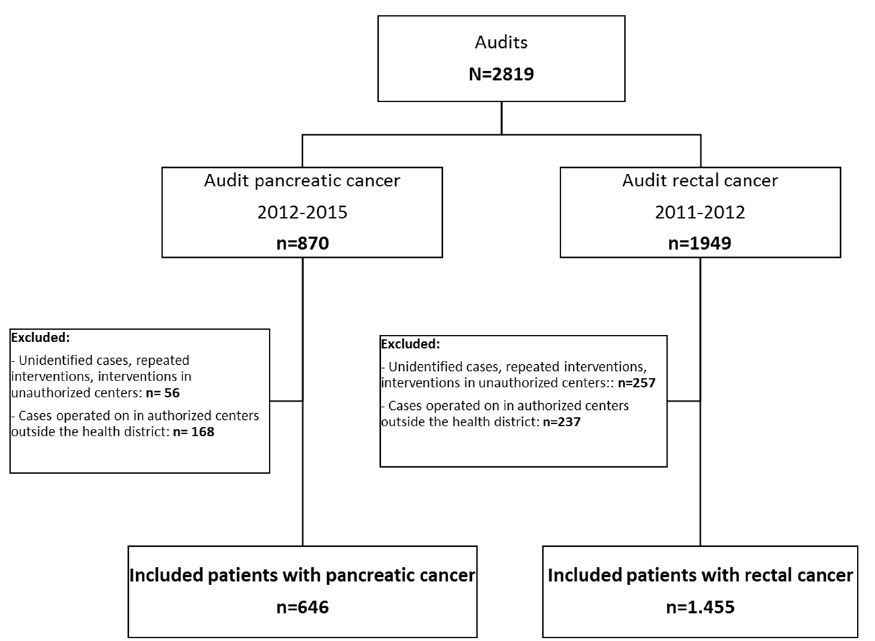
Figure 1. Study flow chart. Table 1. Baseline characteristics of cohort by type of